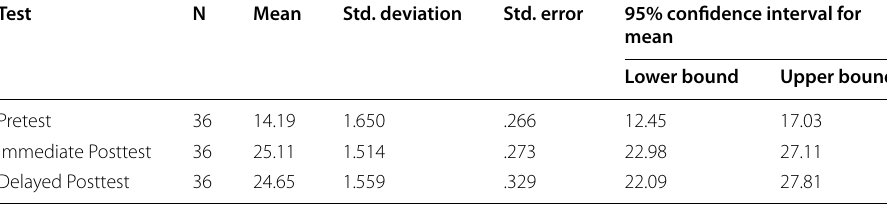
Table 5 Descriptive statistics: pretest, the immediate and delayed posttest scores Test N Mean Std. deviation Std. error 95% confidence interval for